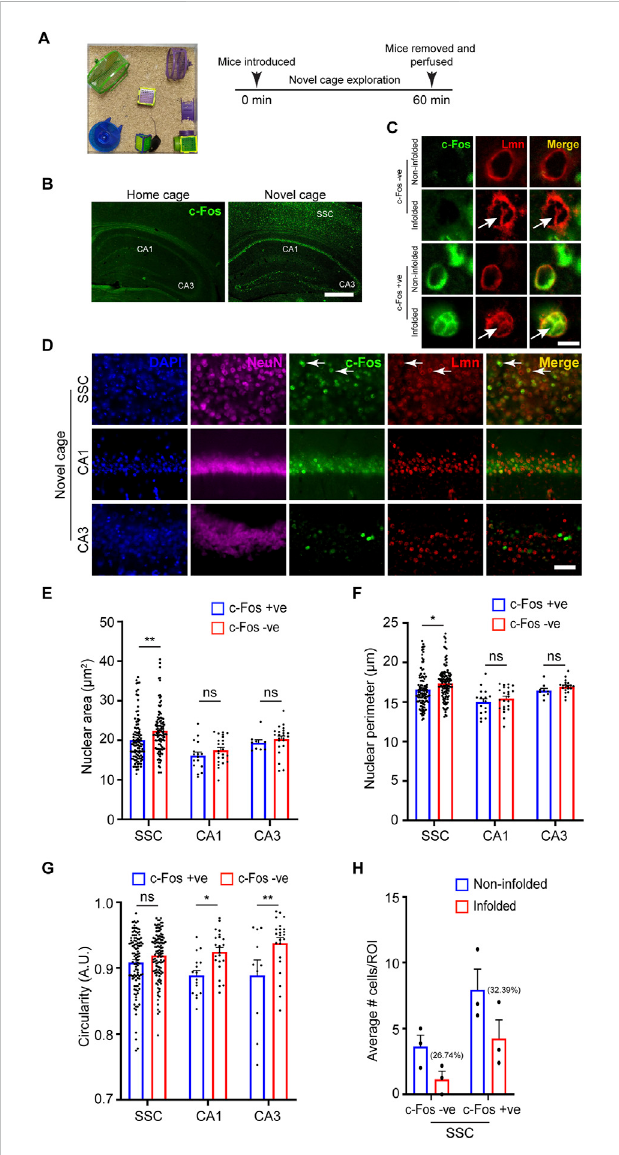
FIGURE 4 Neuronal nuclear morphology following novel environment exploration. (A) Schematic representation of the novel environment and the experimental paradigm. (B) Immunostaining for the activity-induced immediate early gene c-Fos (green) shows robust upregulation of c-Fos in the neurons in the somatosensory cortex and hippocampal regions (white arrows) in novelty explored mice compared to home- caged control mice (Scale bar, 500 µm). (C) Immunostaining using anti- c-Fos (green) and anti-Lmn (red) shows the presence of nuclear infoldings in neurons of the somatosensory cortex (white arrows) (Scale bar, 5 µm). (D) Immunostaining using anti-NeuN (magenta), anti-cFos (green)andanti-Lmn(red)withDNAstainingusingDAPI(blue).Scalebar, 25 µm. White arrows indicate c-Fos-positive neurons. (E – G) Comparison ofmeannucleararea (E) ,perimeter (F) ,andcircularity (G) of c-Fos-negative and c-Fos-positive neurons in the somatosensory cortex and hippocampal CA1 and CA3 regions. (H) Comparison of average number of non-infolded vs. infolded nuclei in c-Fos-positive andc-Fos-negativecells.ROIis0.01 mm 2 , n =3mice.Two-WayANOVA (* p < 0.05, ** p < 0.01, *** p < 0.001 and **** p < 0.0001). Data represented as mean ± SEM. S. cortex, somatosensory